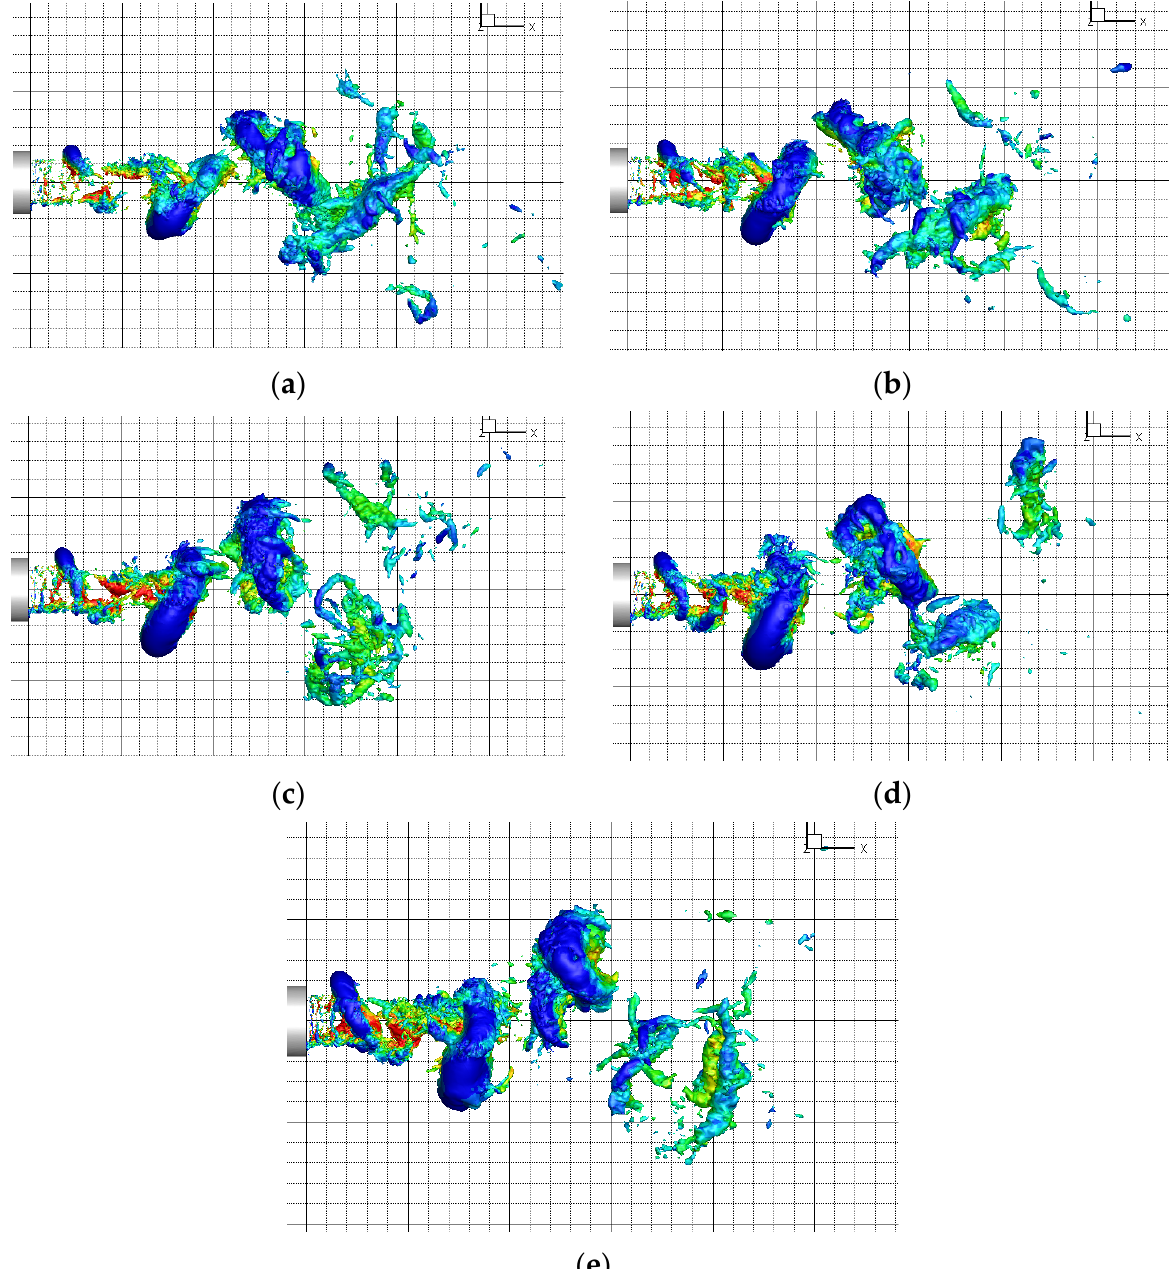
Figure 13. Coherent structures under different amplitudes, visualized by the iso-surface of pressure and colored by the streamwise velocity magnitude, p / ρ U j 2 = − 0.05. ( a ) MFR = 0.67%, ( b ) MFR = 0.83%, ( c ) MFR = 1%, ( d ) MFR = 1.2%, ( e ) MFR = 1.5%.